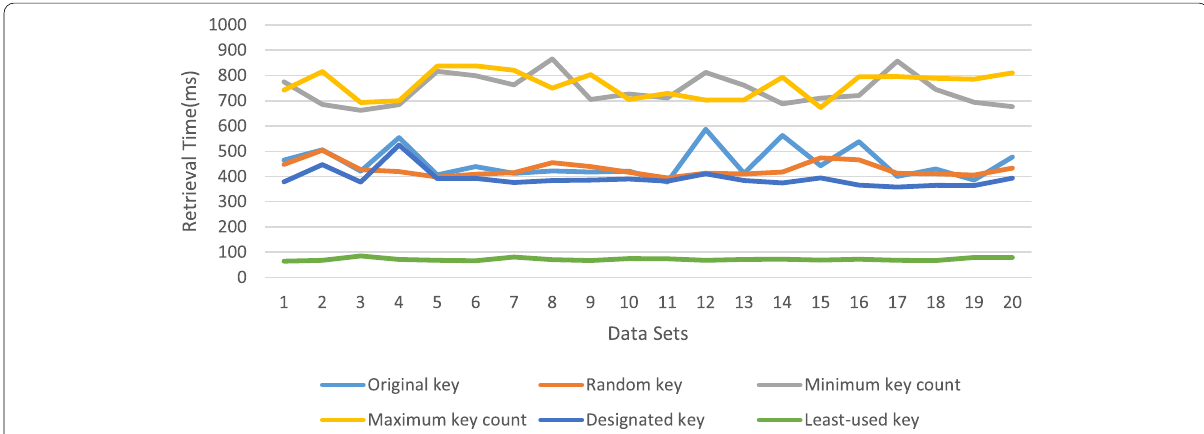
Fig. 11 Retrieval time on primary index models generated using the six different key selection methods with unequal appearing probabilities of parameters in services retrieval